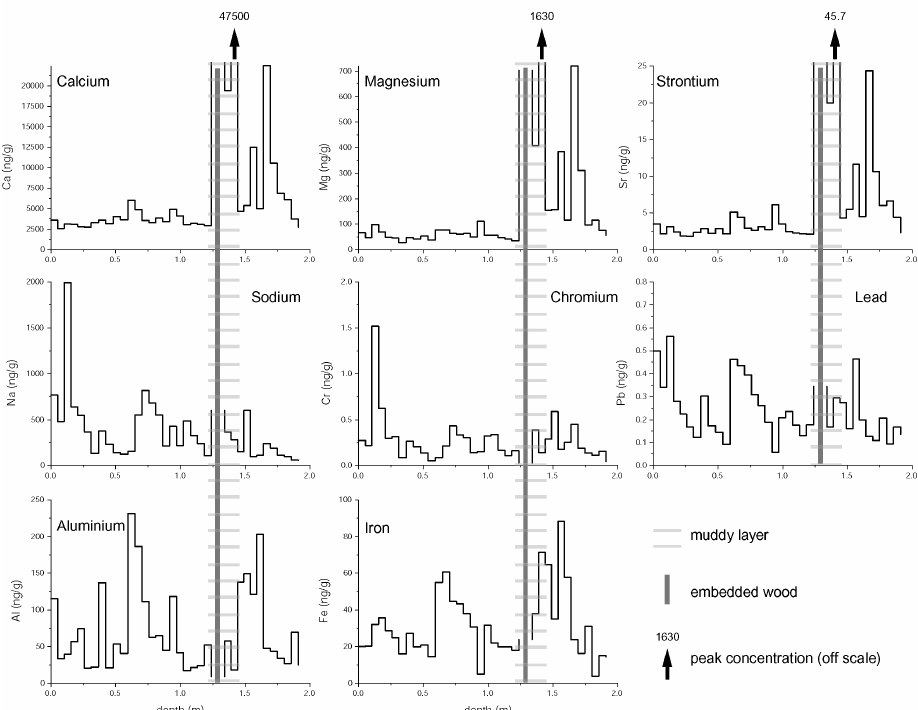
Fig. 6. Concentration profiles of the characteristic elements attributed to the three leading principal components in the Vukuši´c cave ice core. First row (Ca, Mg, Sr) is PC1, second row (Na, Cr, Pb) is PC2 and the third row (Al, Fe) is PC3. The maximum concentrations of the elements in PC1 group located in the deepest sample of the muddy layer are